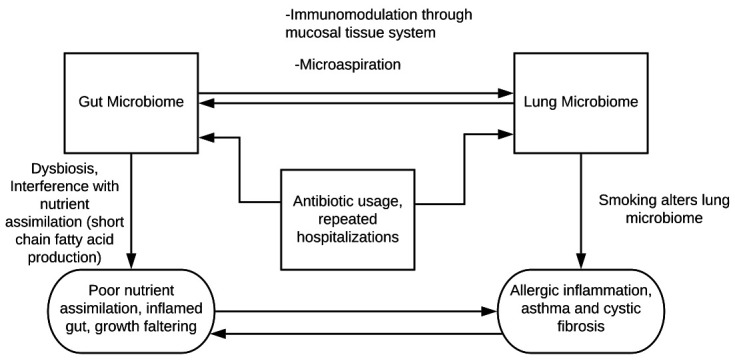
How the impoverished gut may mediate stunting and low lung function.